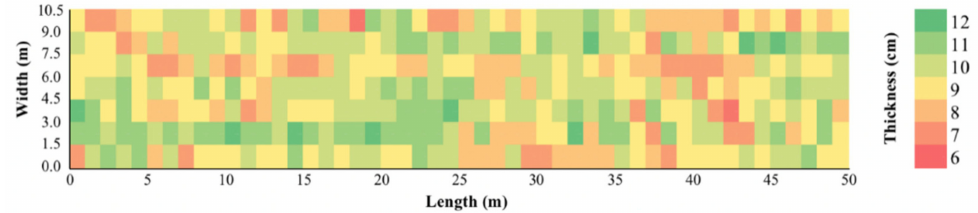
Figure 6. Thickness distribution of the asphalt concrete base in the tested